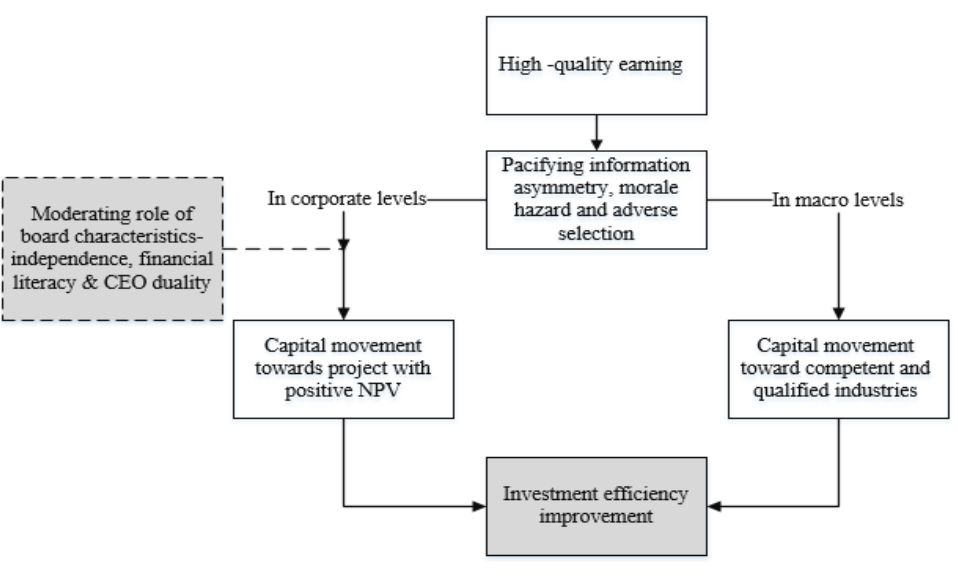
Figure 1. a conceptual framework of the